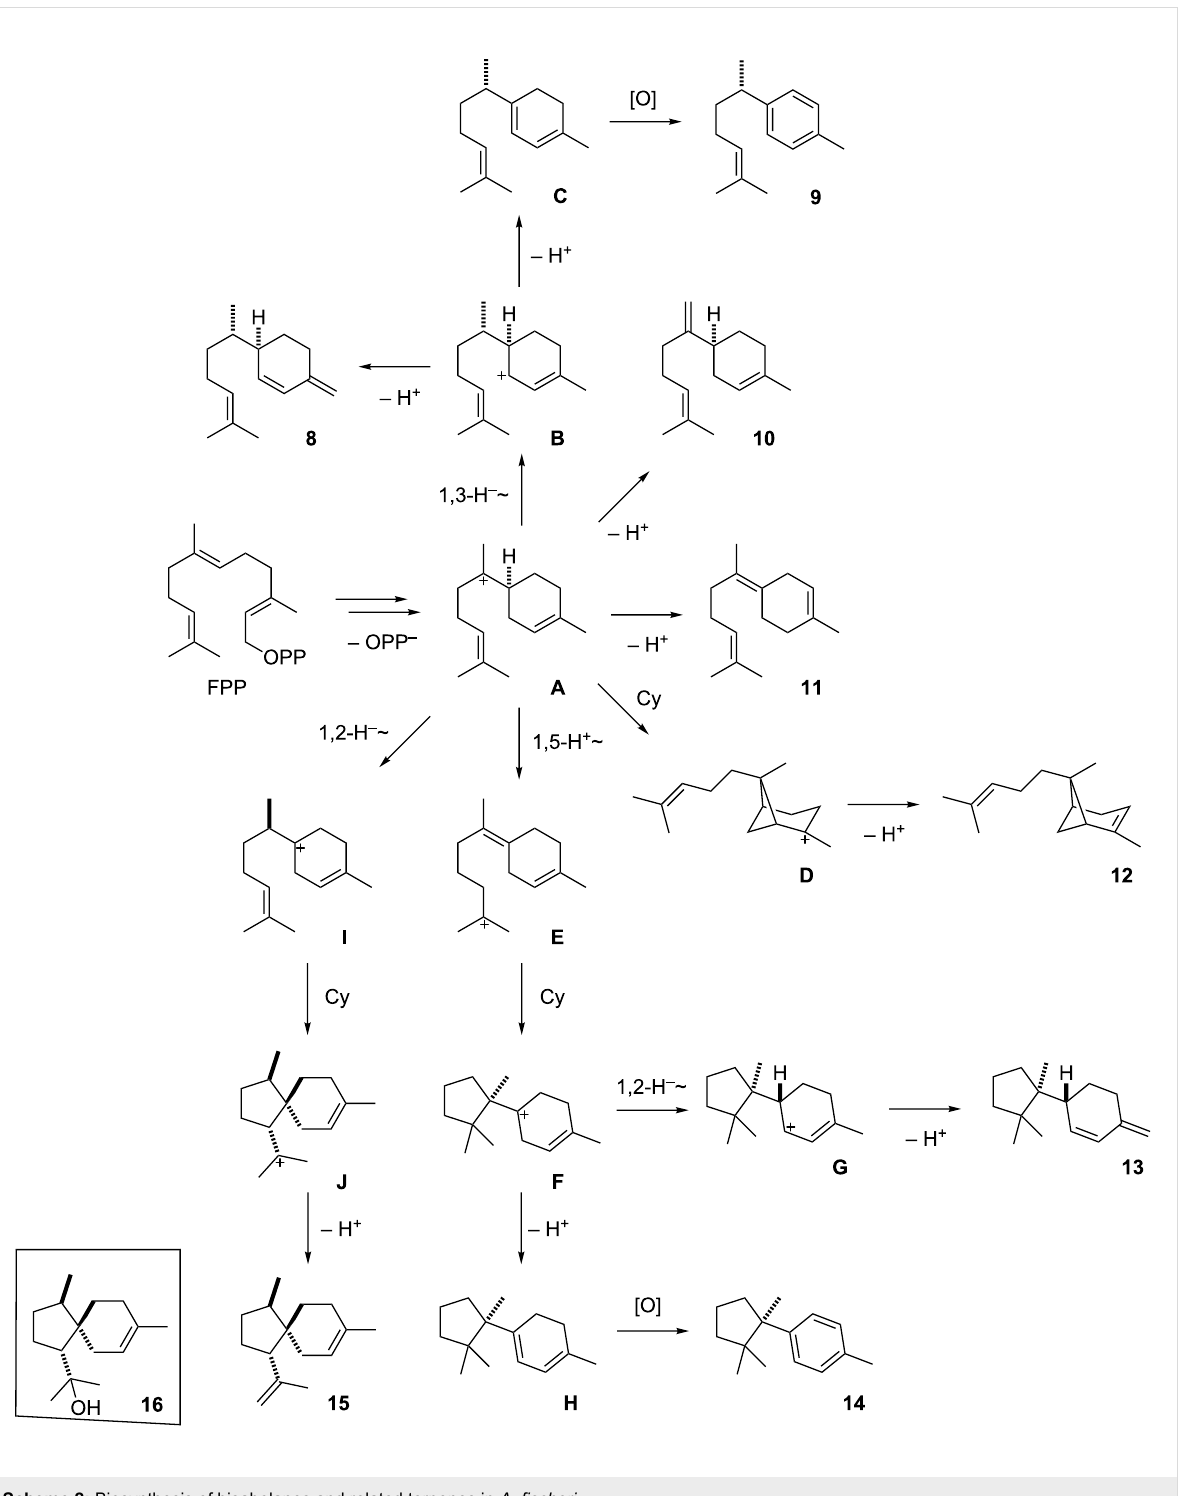
Scheme 2: Biosynthesis of bisabolanes and related terpenes in A. fischeri .